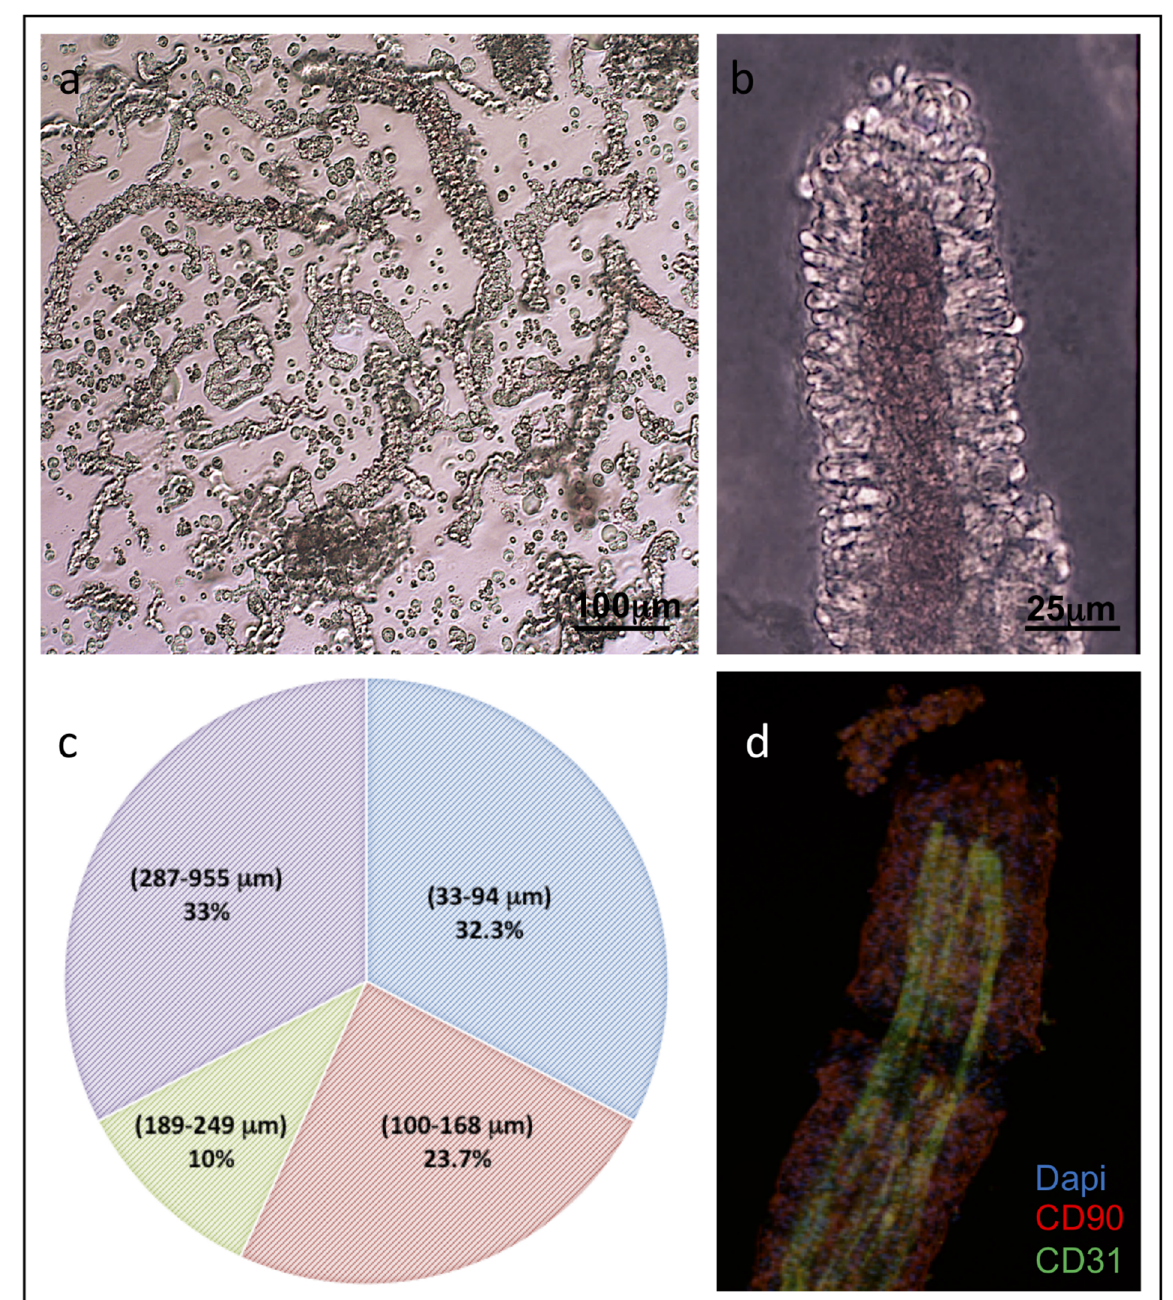
Figure 2. Characterisation of isolated ad-MVFs. ( a ) Optical microscopy of the ad-MVFs; ( b ) optical microscopy of ad-MVF showing larger calibre. ( c ) The percentage distribution of isolated ad-MVFs with lengths ranging from 32.3–955 µ m. ( d ) Immunohistochemical localisation of CD31 (green) in the endothelial cells of the vascular lumen and CD90 (Red) in the pericytes of the perivascular wall. Cell nuclei were stained with DAPI (blue).